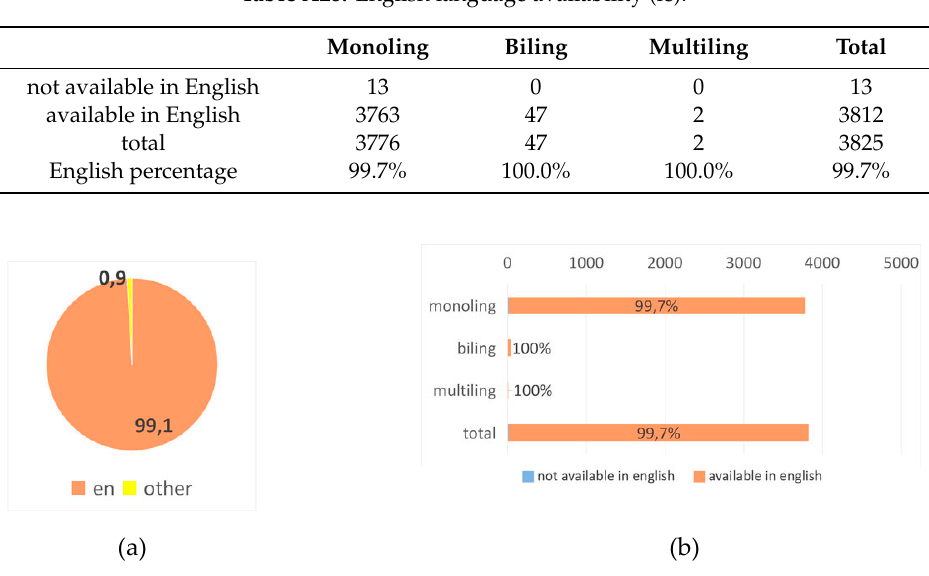
(a) Figure A13. Visualization of the results for domain hu. ( a ) Primary languages pie chart and ( b ) English